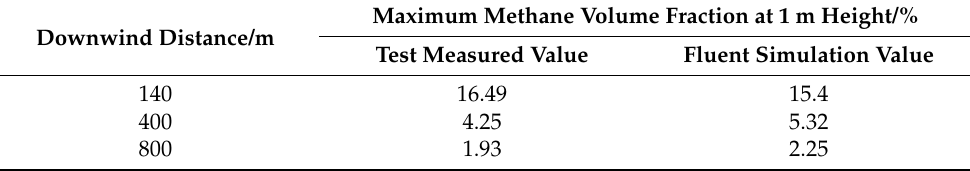
Figure 4. Comparison between experimental and simulated values of methane volume concentration at 57 m in downwind direction. ( a ) Burro-eight test measured value. ( b ) Fluent simulation results. ( c ) Comparison of test and simulation. Table 1. Experimental and simulated values of maximum volume fraction of methane at different distances in downwind direction.